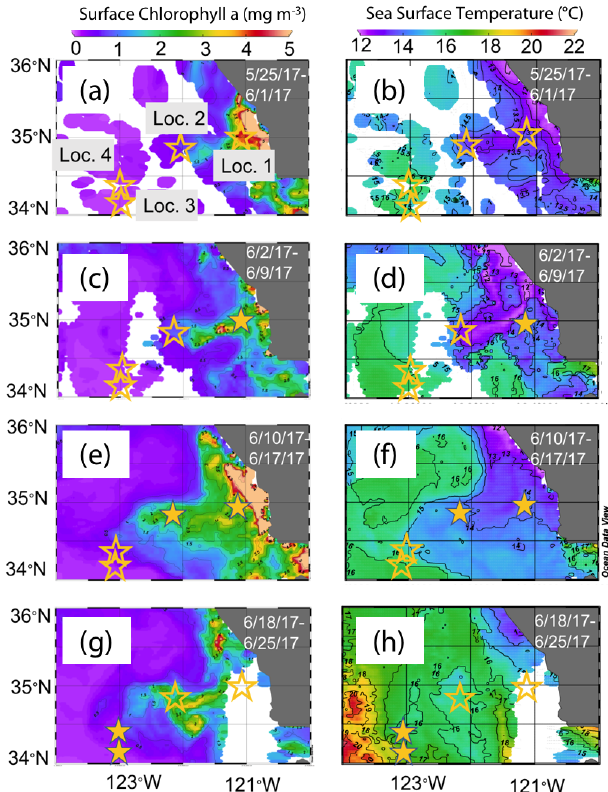
Figure 3. Remotely sensed surface chlorophyll (a, c, e, g) and sea surface temperature (SST) (b, d, f, h) maps of the study area from late May to the end of June 2017. All images are from 4km resolu- tion, 8d averaged data from VIIRS on the Suomi NPP satellite. The stars represent locations 1 to 4 where CFEs were deployed. Stars are filled in the panels most closely corresponding to the time of